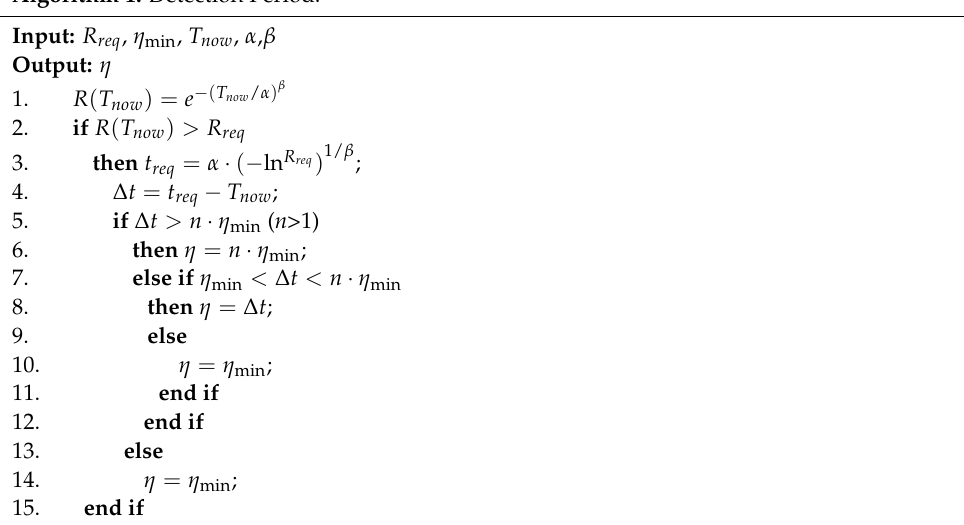
Algorithm 1. Detection